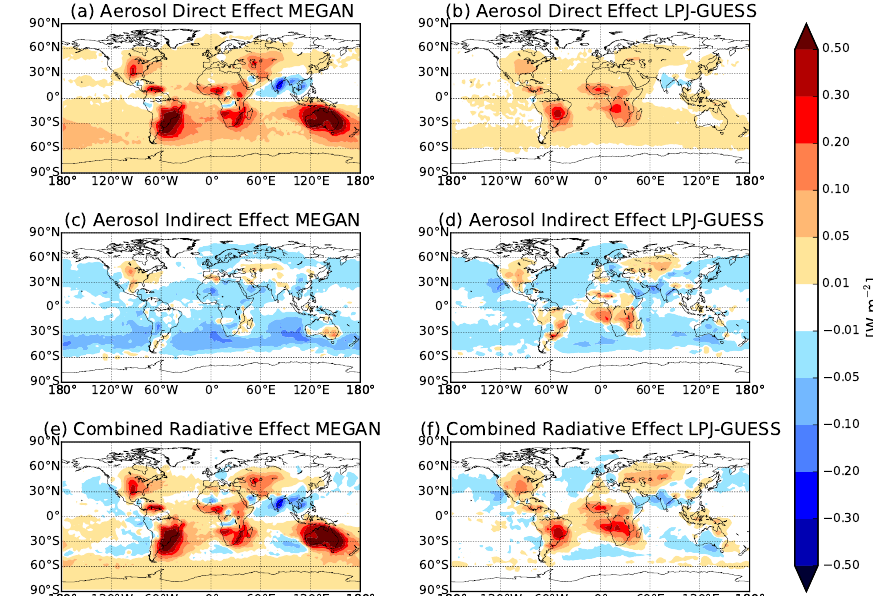
Figure 11. Annual mean change between year 1000 and year 2000 in (a) DRE with MEGAN BVOC emissions and anthropogenic emis- sions off (BE2.AEO.meg–BE1.AEO.meg), (b) DRE with LPJ-GUESS BVOC emissions and anthropogenic emissions off (BE2.AEO.LPJ– BE1.AEO.LPJ), (c) AIE with MEGAN BVOC emissions and anthropogenic emissions off, (d) AIE with LPJ-GUESS BVOC emissions and anthropogenic emissions off, (e) combined radiative effect with MEGAN BVOC emissions and anthropogenic emissions off, and (f) combined radiative effect with LPJ-GUESS BVOC emissions and anthropogenic emissions off. Global mean changes are + 0.065, + 0.022, − 0.020, − 0.008, + 0.049, and + 0.015Wm − 2 , respectively (see Table